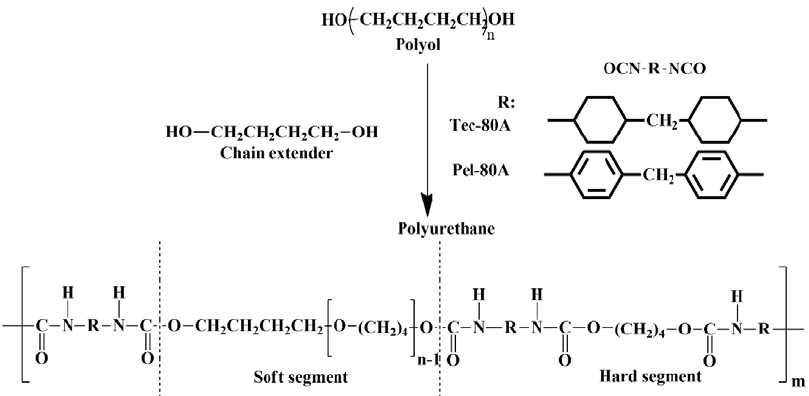
Figure 2. Structures of Tec-80A and Pel-80A polyurethanes.